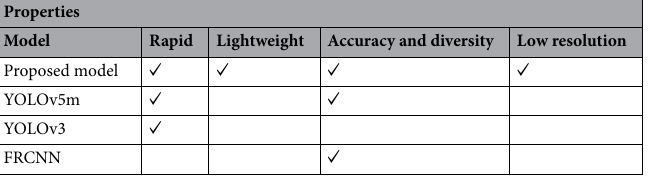
Table 3. Comparative overview of key properties across